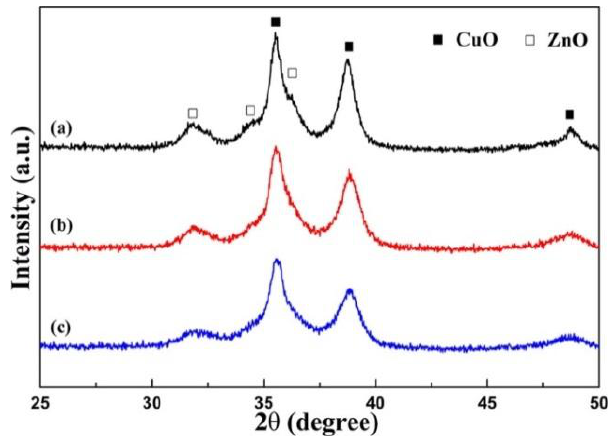
Figure 18. XRD patterns of CZAx catalysts (x = 200 ( a ), 300 ( b ), and 400 ( c )). Reprinted from Wu, W.; Xie, K.; Sun, D.; Li, X.; Fang, F. CuO/ZnO/Al 2 O 3 Catalyst Prepared by Mechanical-Force-Driven Solid-State Ion Exchange and Its Excellent Catalytic Activity under Internal Cooling Condition. Ind. Eng.